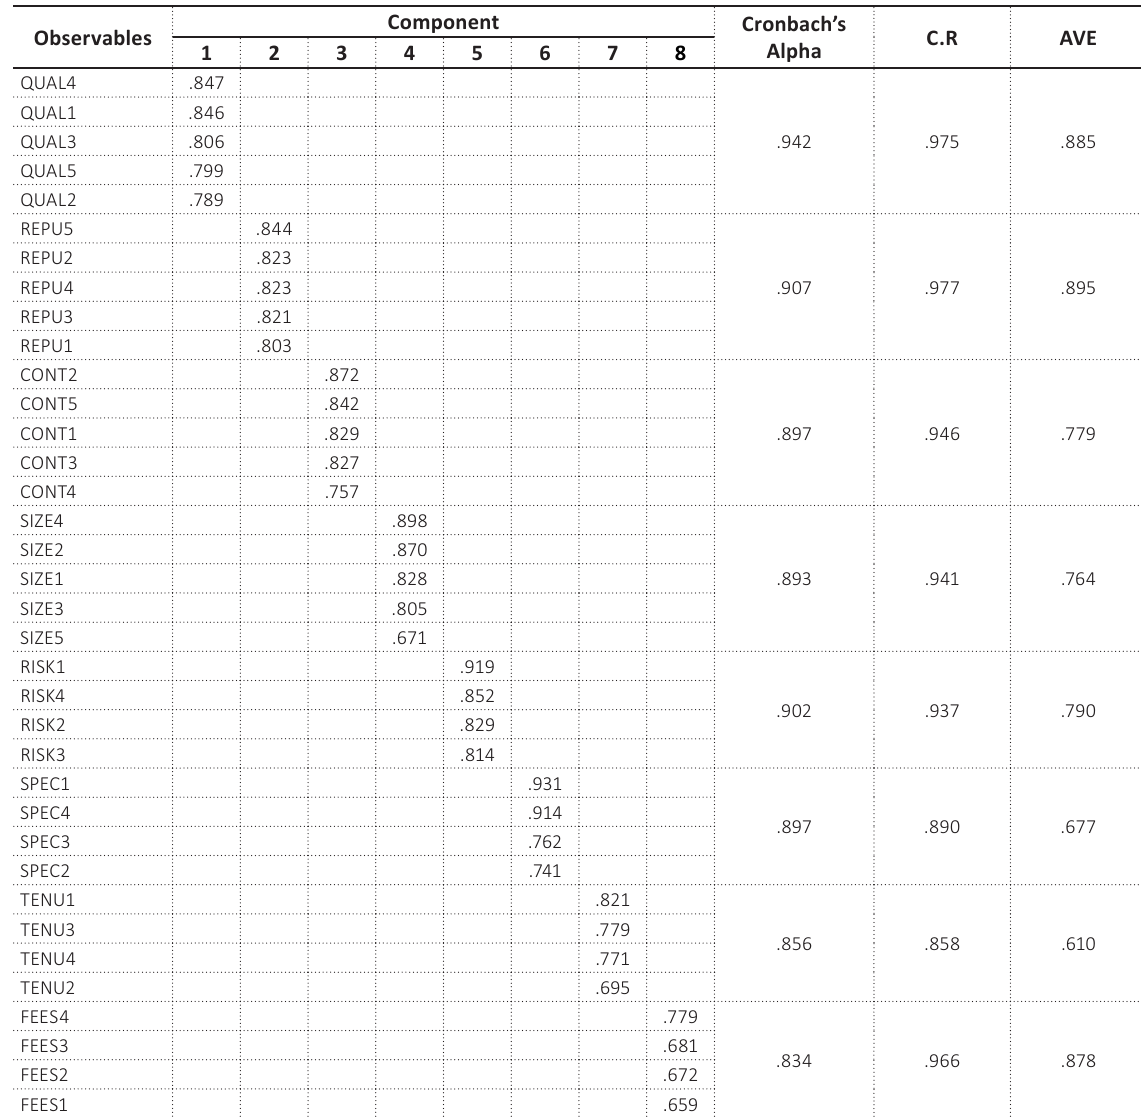
Table 3. Matrix results of factors and CRA, composite reliability, average variance extracted from